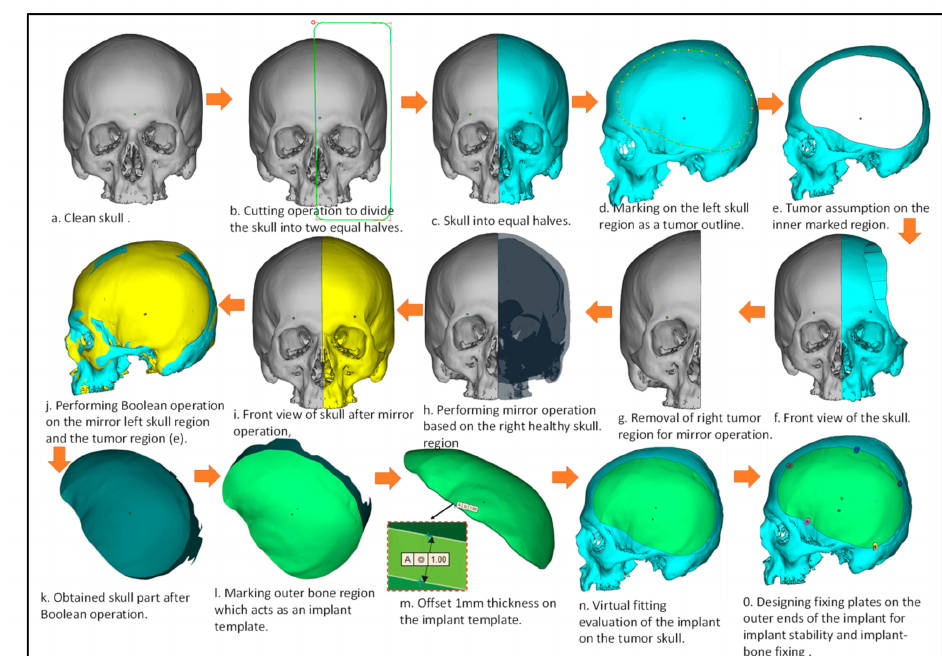
Figure 2. Workflow for the reconstruction of customized cranial